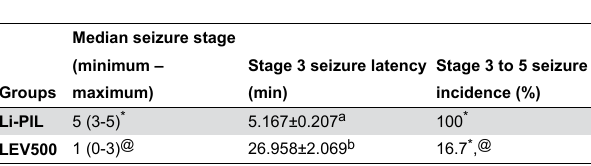
Table 1. Effect of Levetiracetam (LEV, 500 mg/kg i.p.) on lithium-pilocarpine (Li-PIL) -induced seizures in rats.